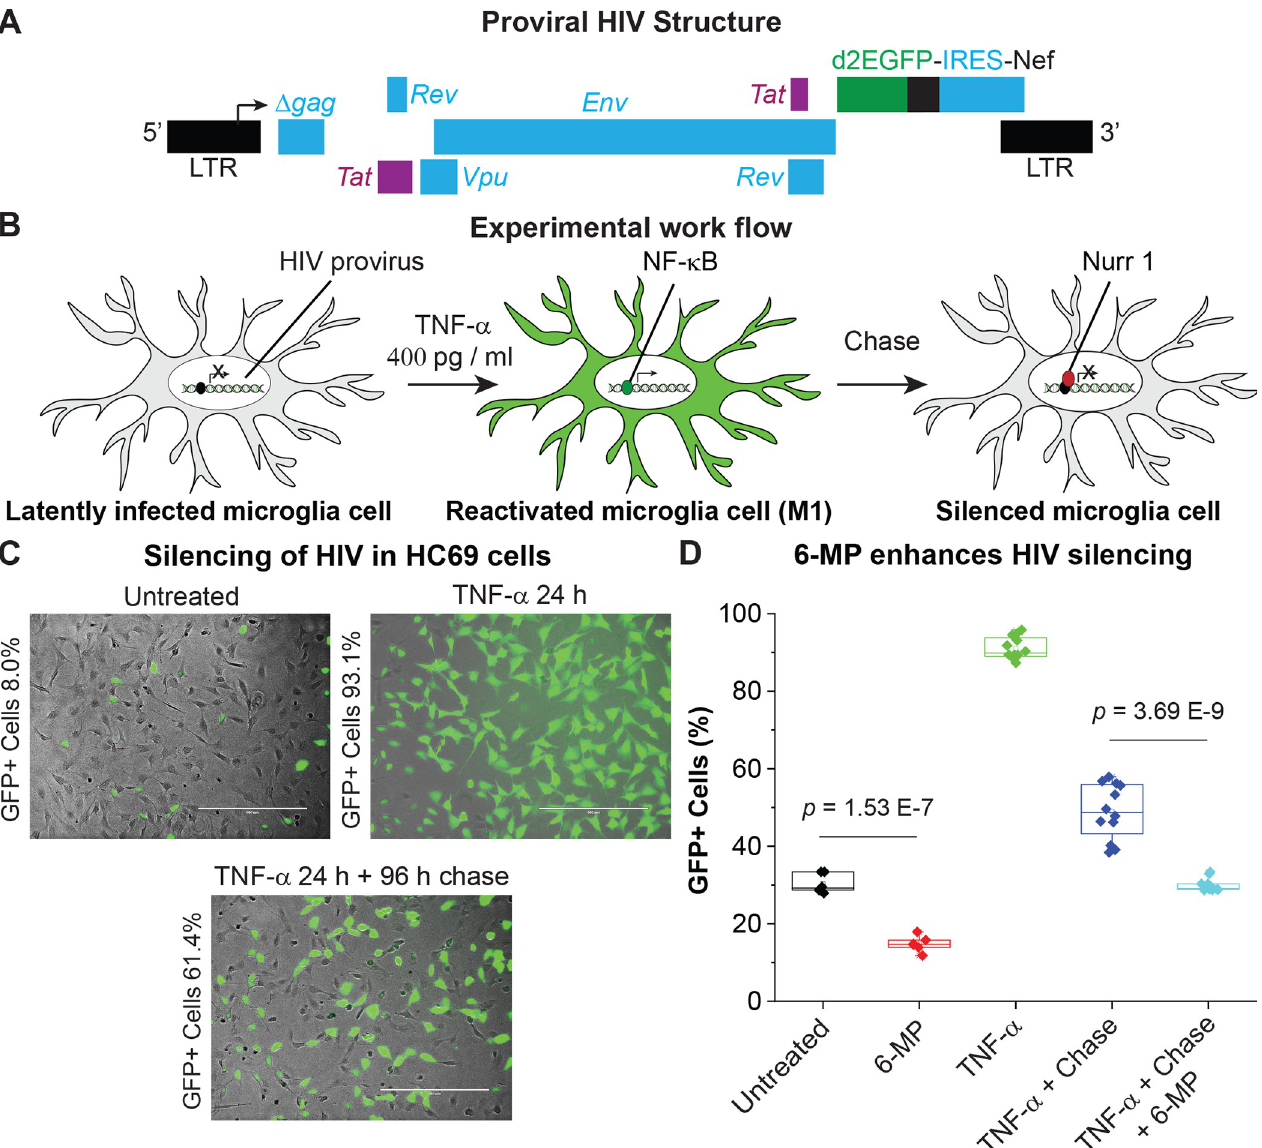
Fig 1. Accelerated silencing of HIV in microglial cells by the Nurr1/Nor1 agonist 6-MP. A , genome organization of a d2EGFP reporter HIV-1 that was cloned in the lentiviral vector pHR’. A fragment of HIV-1 pNL4-3 , containing Tat , Rev , Env , Vpu and Nef with the green fluorescence reporter gene d2EGFP, was cloned into the lentiviral vector pHR’. The resulted plasmid was used to produce the VSV-G HIV particles as described previously [122]. Immortalized human microglial cells (h μ glia) were infected with the lenti-HIV viral particles, generating multiple clones with an integrated pro-virus genome. HC69 was a representative of these clones. B, Schematic diagram of experimental scheme to study the role of nuclear receptors in microglial reactivation and reversion to latency. C, Representative phase contrast, GFP, and overlapped images of HC69 cells that were cultured in the absence (untreated, left panel) and in the presence of TNF- α (400 pg/ml) for 24 hr (TNF- α 24 h, middle panel) respectively, or used in a chase experiment by continuously culturing HC69 cells in the absence of TNF- α for 96 hr after stimulating the cells with TNF- α (400 pg/ml) for 24 hr and washing with PBS (TNF- α 24 h+96 h, right panel). The average percentages of GFP+ cells indicated for each panel were measured by flow cytometry from triplicate wells. D , Impact of Nurr1 agonist 6-MP on HIV silencing. Quantitative flow cytometry results from 9 independent experiments performed over a period of 2 years are shown. The p -values of pair-sample, Student’s t - tests comparing untreated cells and cells treated with 1 μ M 6-MP are